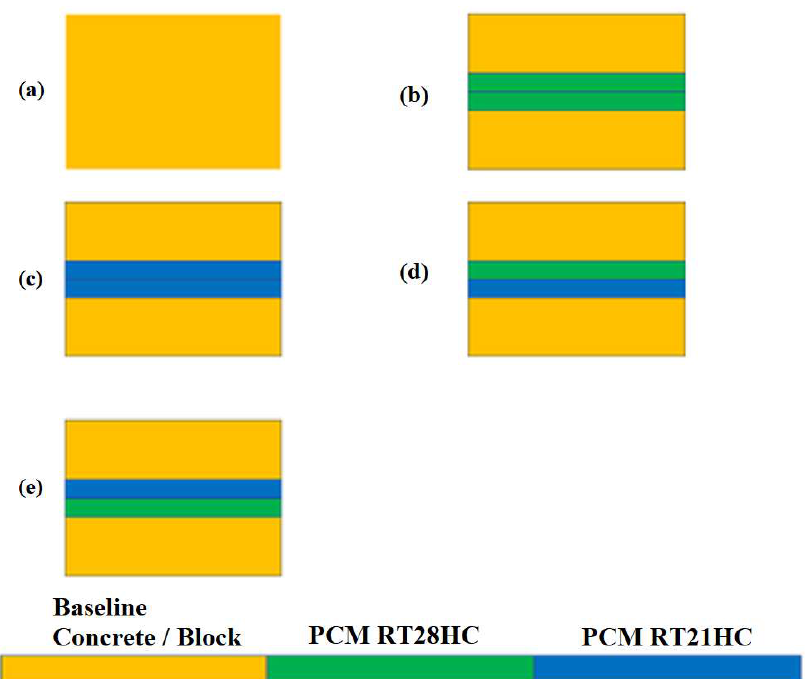
Figure 3. Schematic of test samples ( a ) Baseline concrete or cement block ( b ) PCM RT28HC–RT28HC ( c ) PCM RT21HC–RT21HC ( d ) PCM RT28HC–RT21HC ( e ) PCM RT21HC–RT28HC.